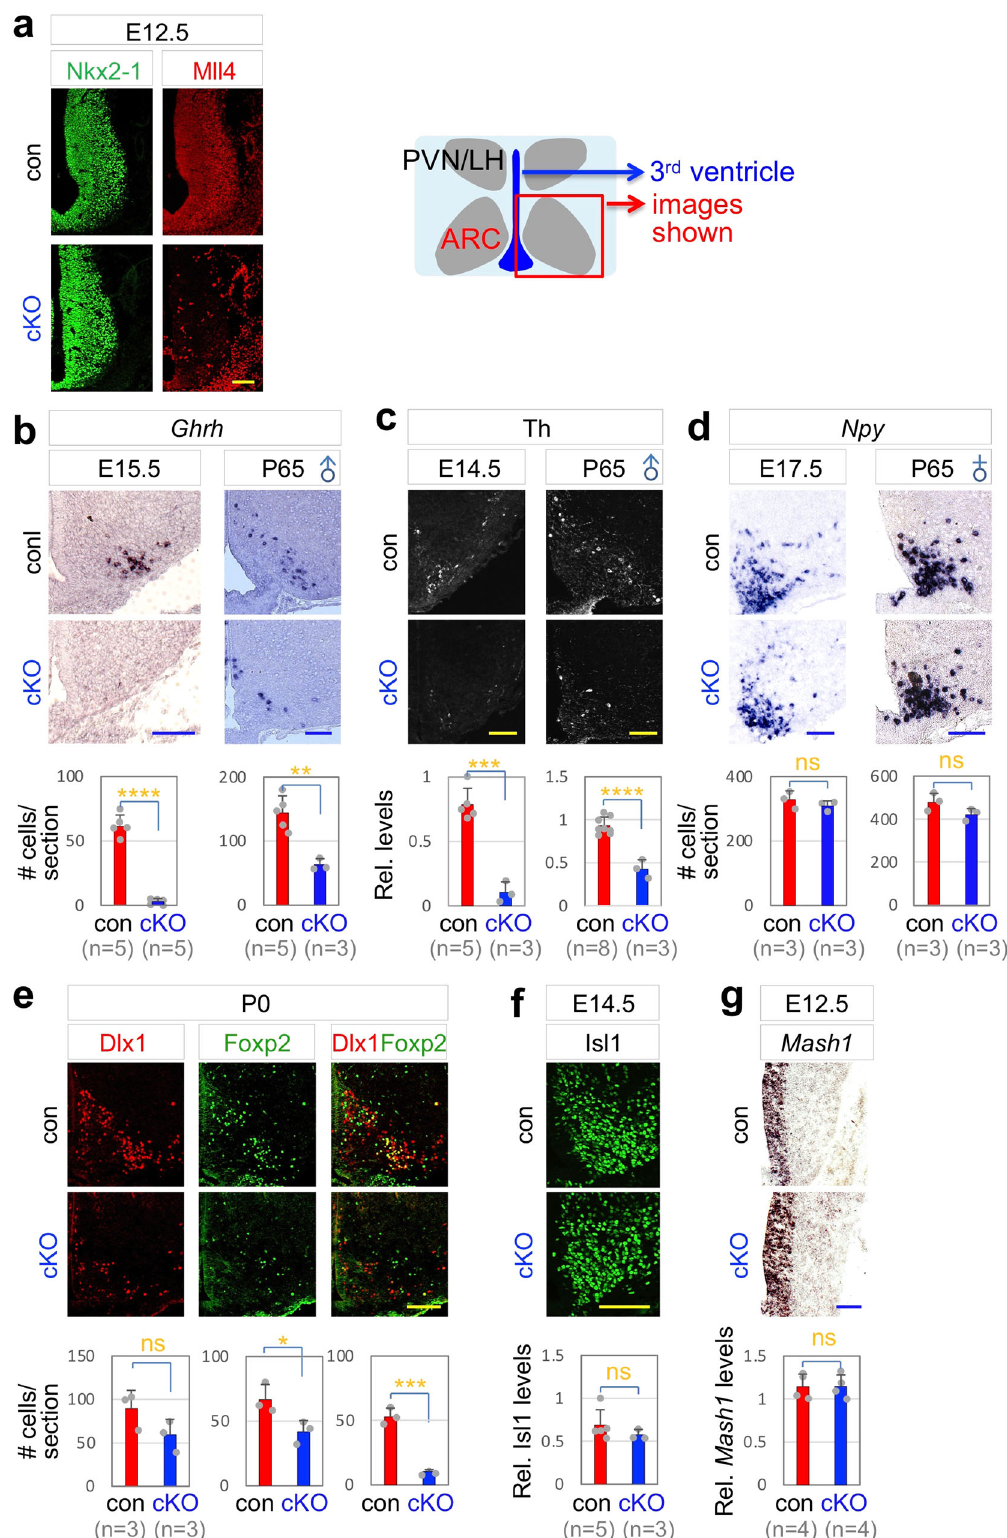
ARC neurons, which revealed 83 genes that are most speci fi cally enriched in developing GHRH-neurons relative to other ARC neuronal types 10 . Among the 83 genes, 7 genes recruit both